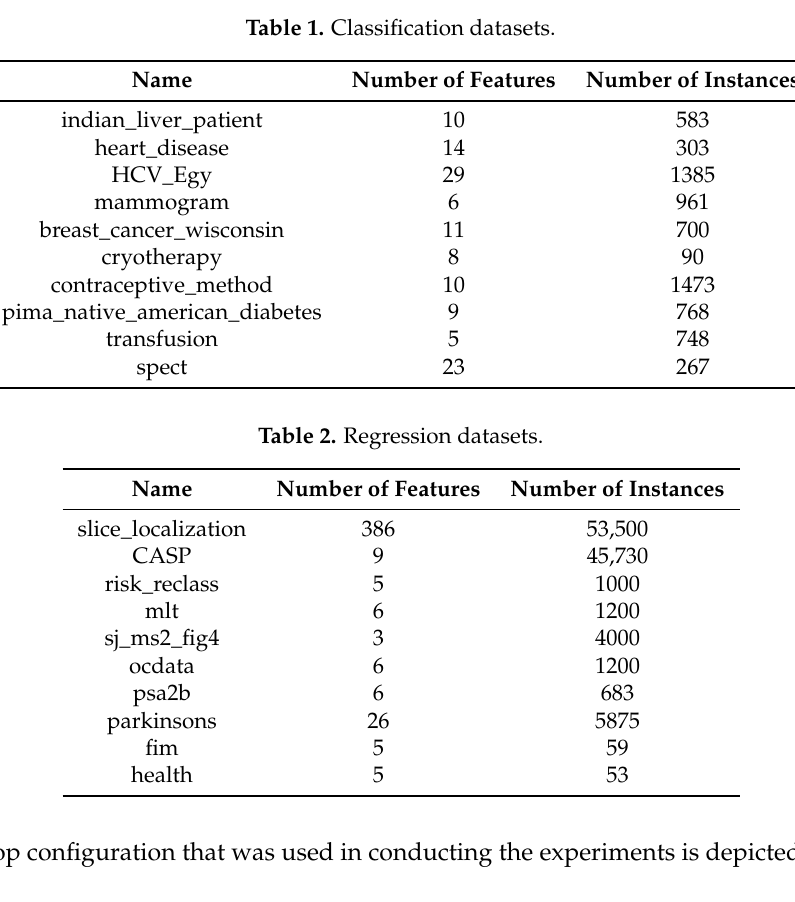
Table 3. Laptop configuration.